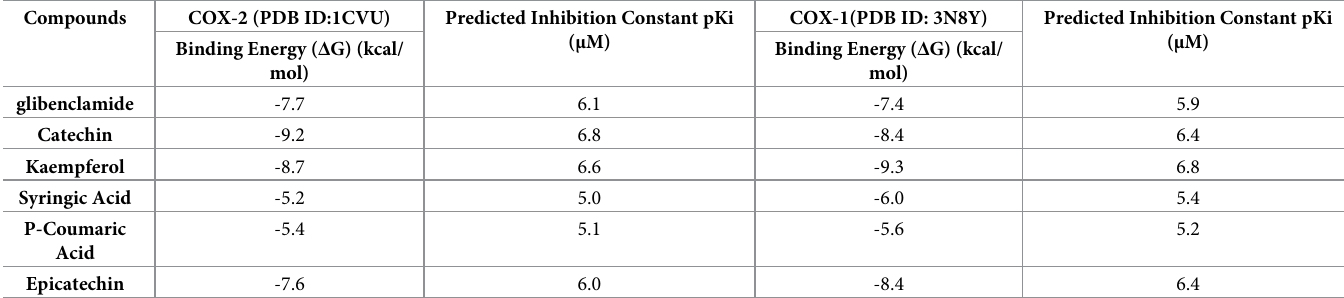
Table 7. In silico molecular docking results of GLB and bioactive phytochemicals interaction with inflammation responsible receptors. Compounds